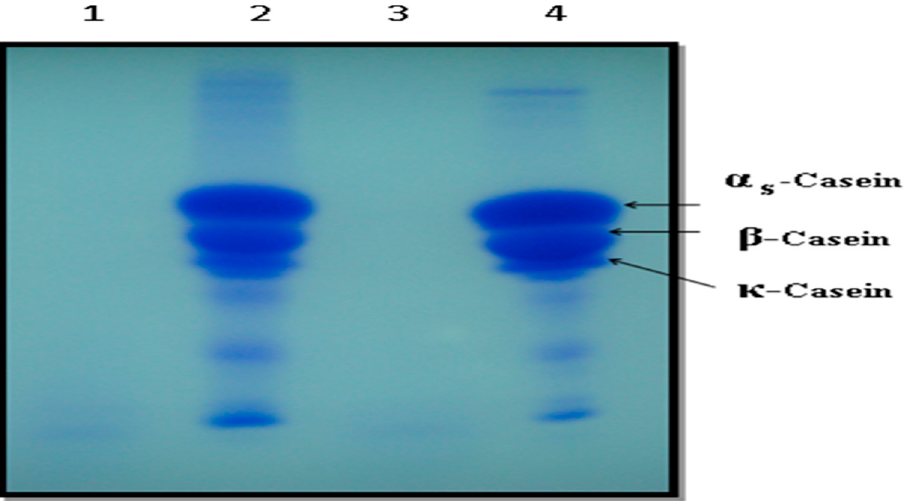
Figure 2. SDS-PAGE profile of cow and camel milk casein hydrolysis. Lane 1 : camel milk casein treated with trypsin for one hour, Lane 2 : camel milk casein (untreated) , Lane 3 : cow milk casein treated with trypsin for one hour, Lane 4 : cow milk casein (untreated).